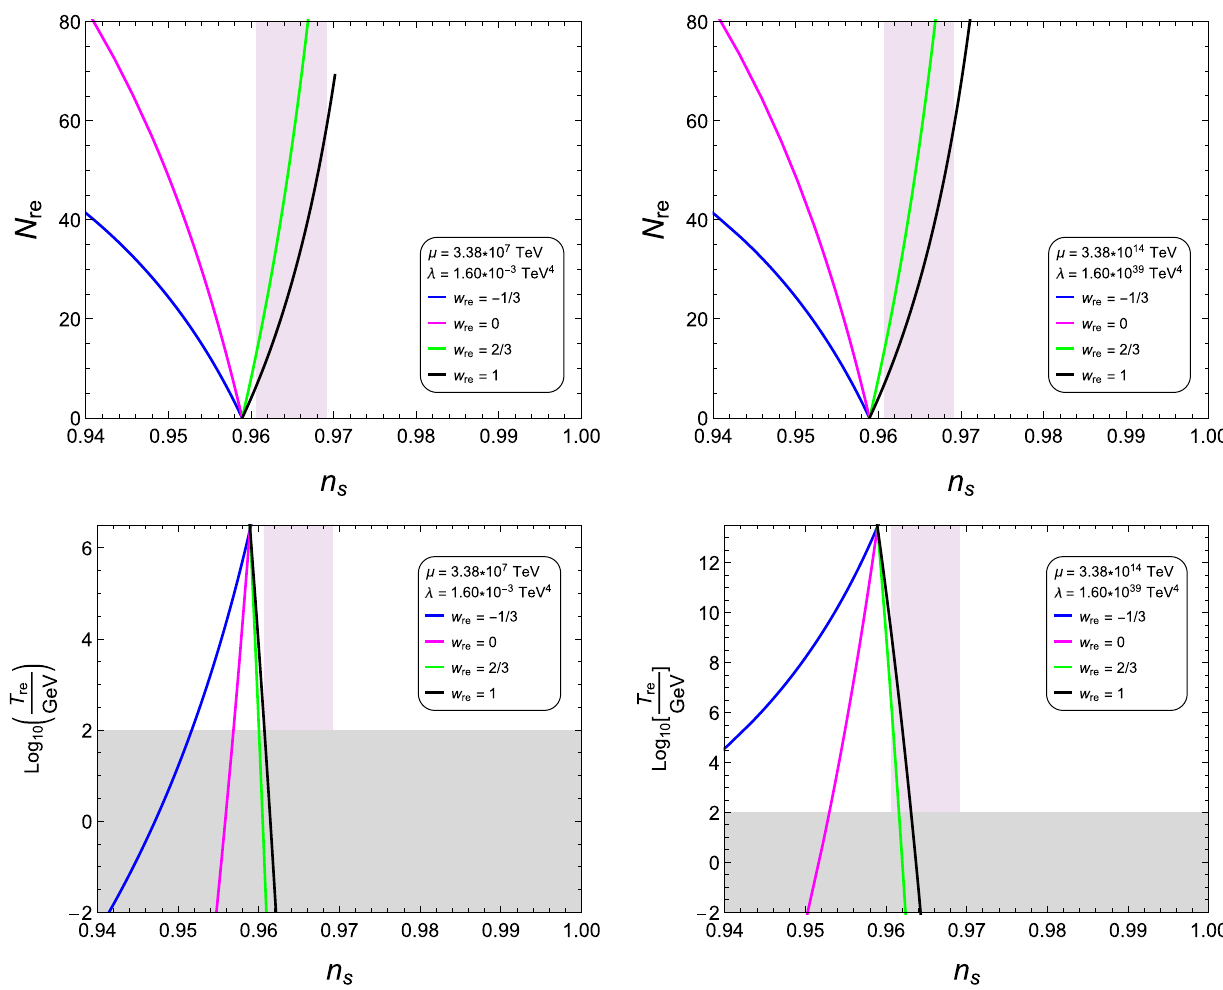
Fig. 10 Plots of N re and T re as functions of n s for Higgs-like inflation. The left panels shows the plots for M 5 = 10 5 TeV while the right panels shows the plots for M 5 = 10 12 TeV. The curves and the shading regions are the same as Fig. 3 and all plots corresponds to α = 0 . 0115